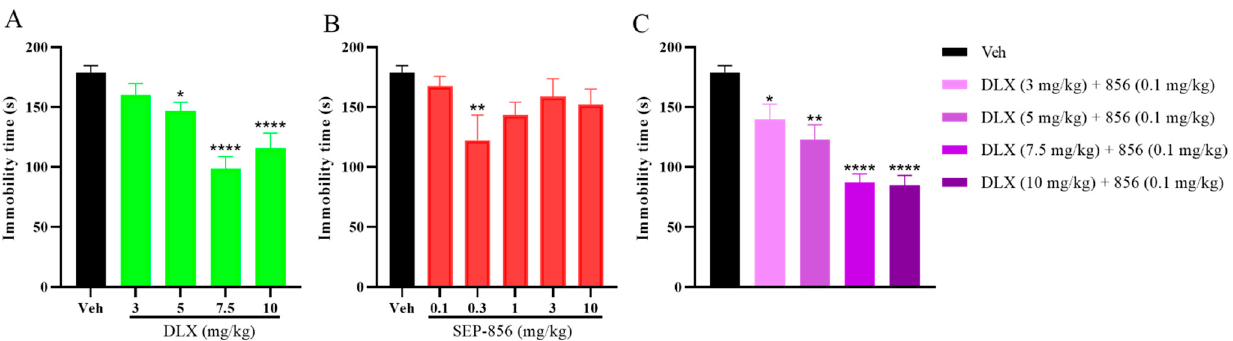
Figure 2. Effects of duloxetine, SEP-856, and their co-administration on the TST in ICR mice. ( A ) Effects of duloxetine (3, 5, 7.5, and 10 mg/kg, p.o.) on behavioral despair in the TST 60 min after administration. ( B ) Effects of SEP-856 (0.1, 0.3, 1, 3, and 10 mg/kg, p.o.) on behavioral despair in the TST 60 min after administration. ( C ) Effects of co-administration of duloxetine (3, 5, 7.5, and 10